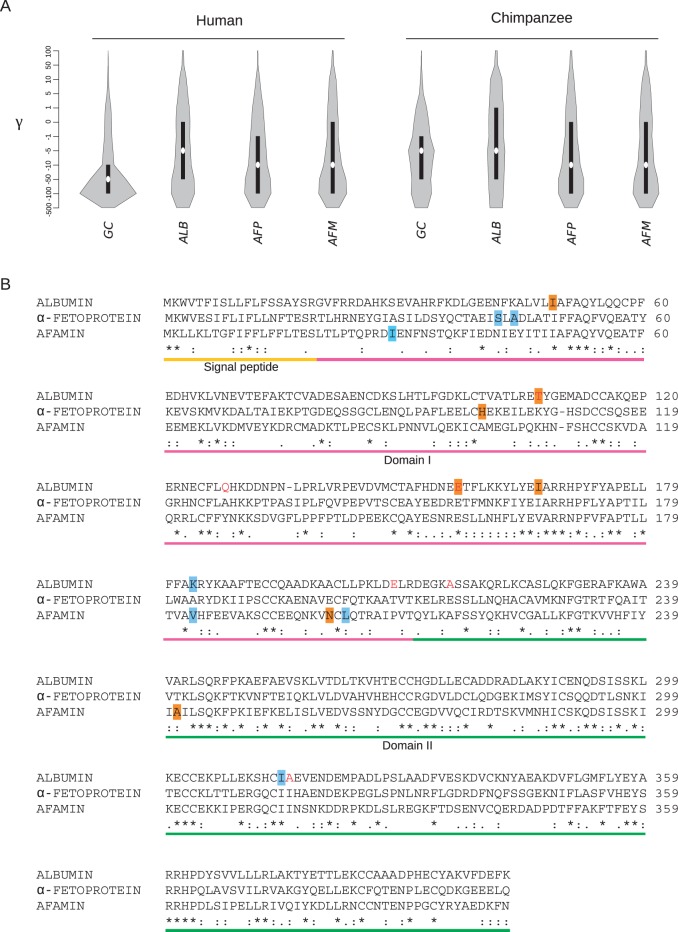
Analysis of selective pressure in the human and chimpanzee lineages. (A) Violin plot of selection coefficients (median, white dot; interquartile range, black bar). Selection coefficients (γ) are classified as strongly beneficial (100, 50), moderately beneficial (10, 5), weakly beneficial (1), neutral (0), weakly deleterious (−1), moderately deleterious (−5, −10), strongly deleterious (−50, −100), and inviable (−500). (B) Multiple alignment of human ALB, AFM, and AFP. Positively selected sites in the human (cyan) and chimpanzee (orange) lineages are highlighted. Sites selected in whole phylogeny are reported in red. Protein domains are indicated below the alignment: Signal peptide in yellow, domain I in magenta, and domain II in green.